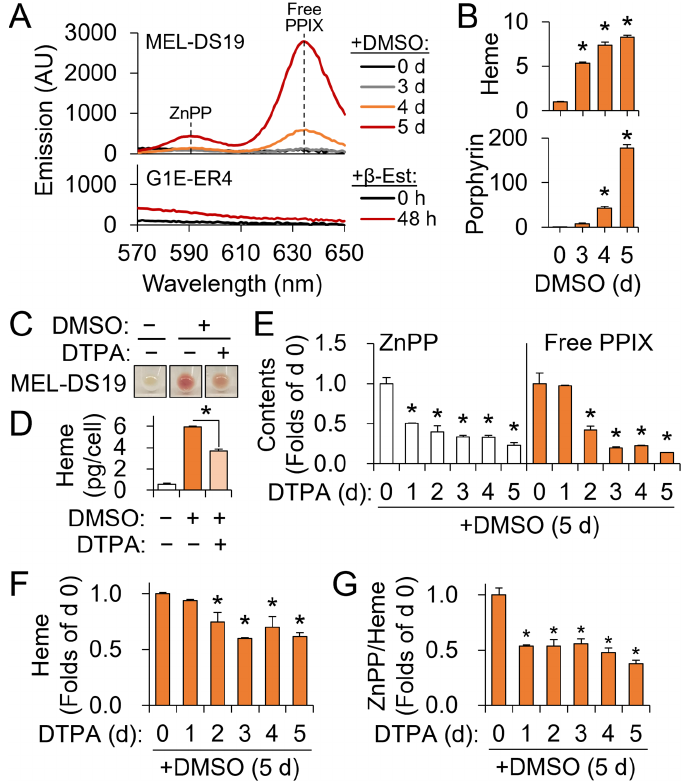
Figure 4. Zinc restriction results in lower heme, zinc protoporphyrin, and free protoporphyrin pro- duction by MEL-DS19 cells induced for hemoglobinization. ( A ) Fluorescence spectra of free PPIX